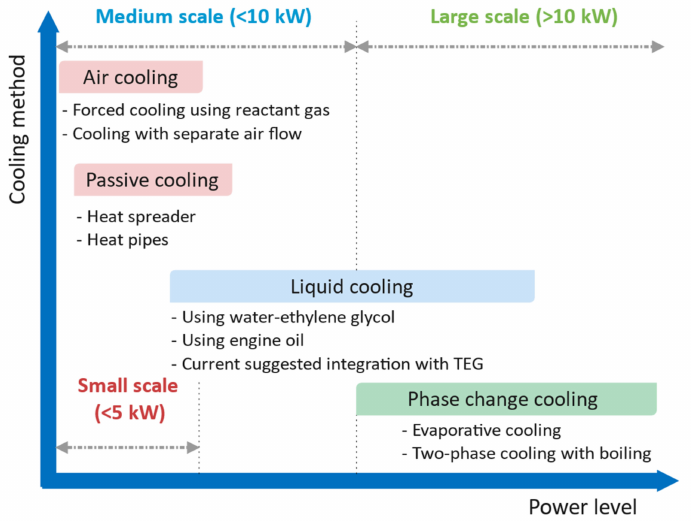
Figure 3. Different cooling methods based on the size of the PEMFC stack.